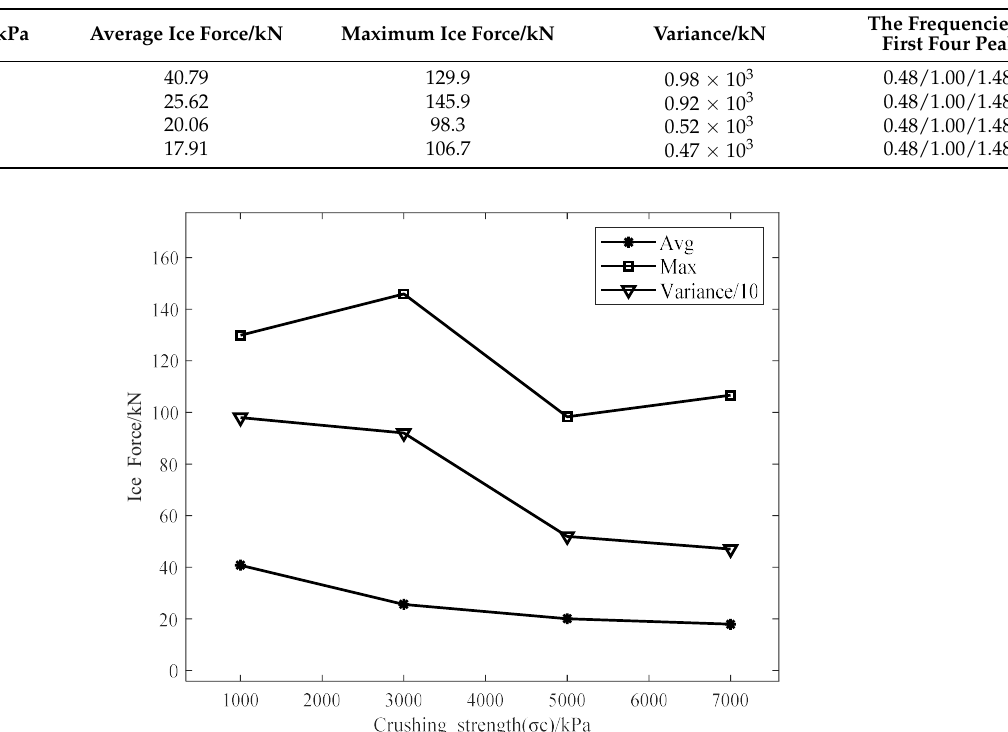
Table 9. Statistics of ice force under different crushing strength ( σ c ).